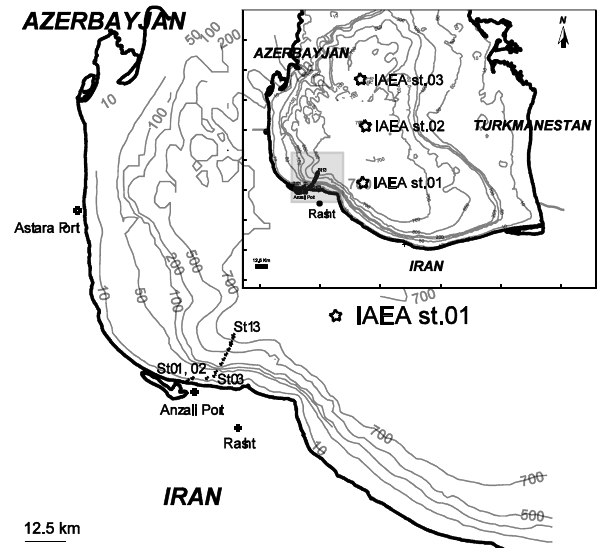
Fig. 1 Fig. 1. The study area and CTD stations in the south western waters of the Caspian